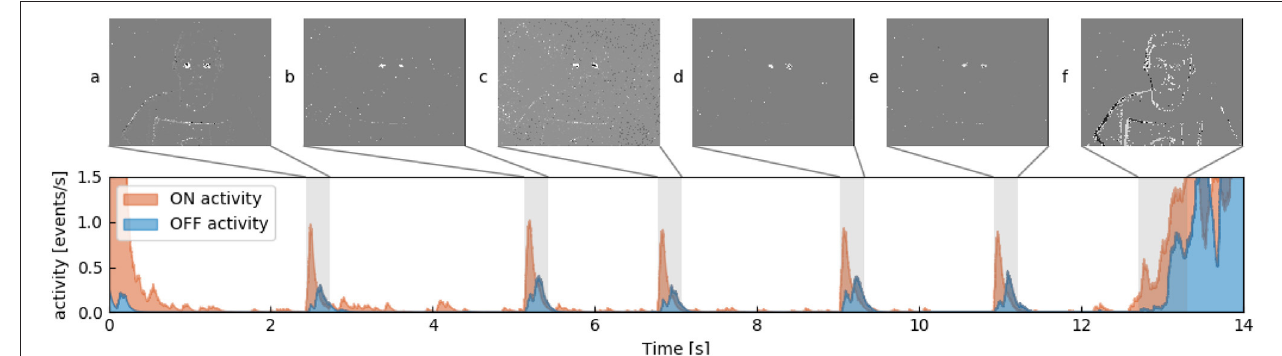
FIGURE 3 | Showing ON (red) and OFF (blue) activity for one tile which lines up with one of the subject’s eyes. Multiple snapshots of accumulated events for 250ms are shown, which corresponds to the gray areas. (A–E) Blinks. Subject is blinking. (F) Subject moves as a whole and a relatively high number of events is generated.